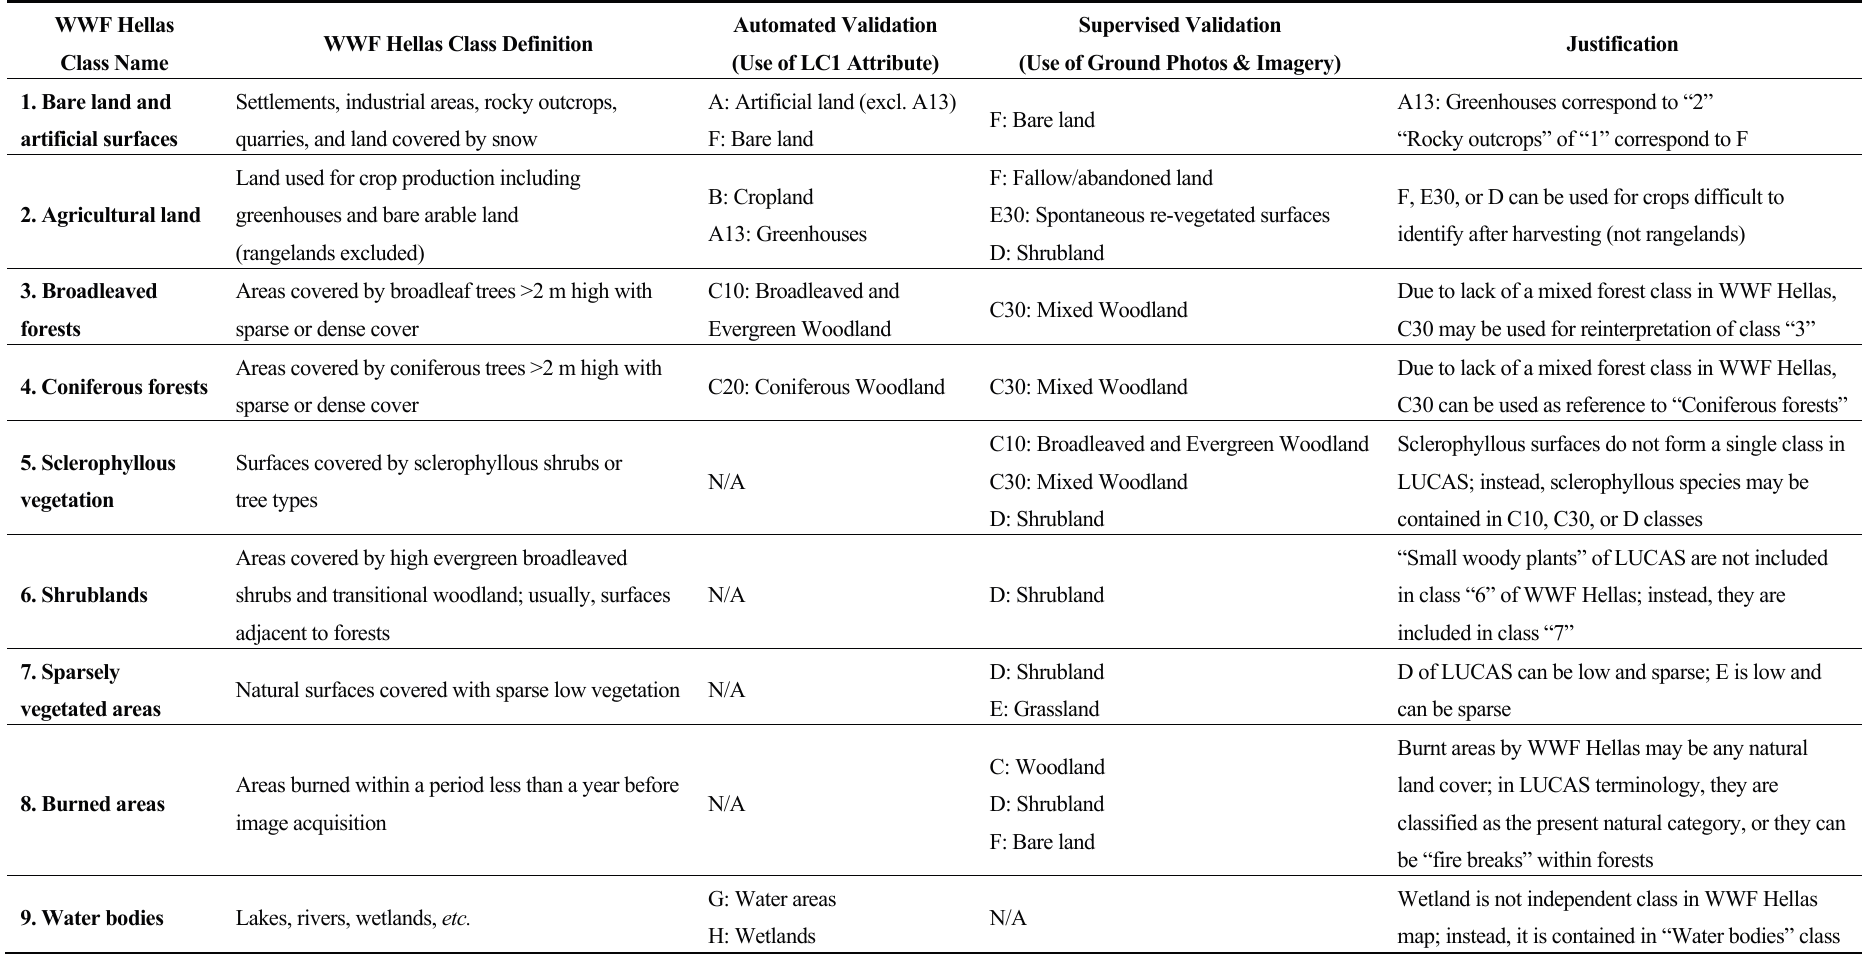
Table 4. A summary of the thematic agreement between the classification scheme (WWF Hellas map 2007) and the reference nomenclature (LUCAS 2009) in terms of inter-class relations in a table of